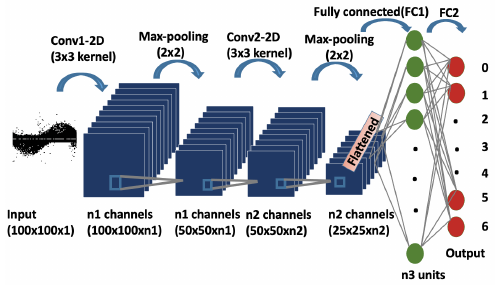
Figure 6. Simple CNN